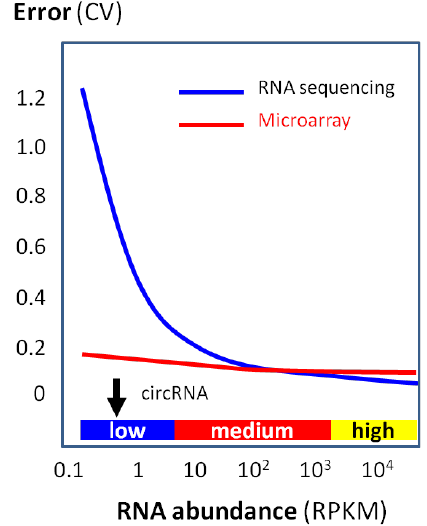
Figure 9. Quantification accuracy (i.e., low error) with RNA abundance by using a microarray or RNA sequencing. Data are based on a large-scale clinical study [52]. While RNA sequencing rapidly loses accuracy (i.e., high error) when the RNA abundance is low, microarray accuracy is relatively unaffected even with a low RNA abundance. Typical circRNA abundance is indicated by the black arrow.